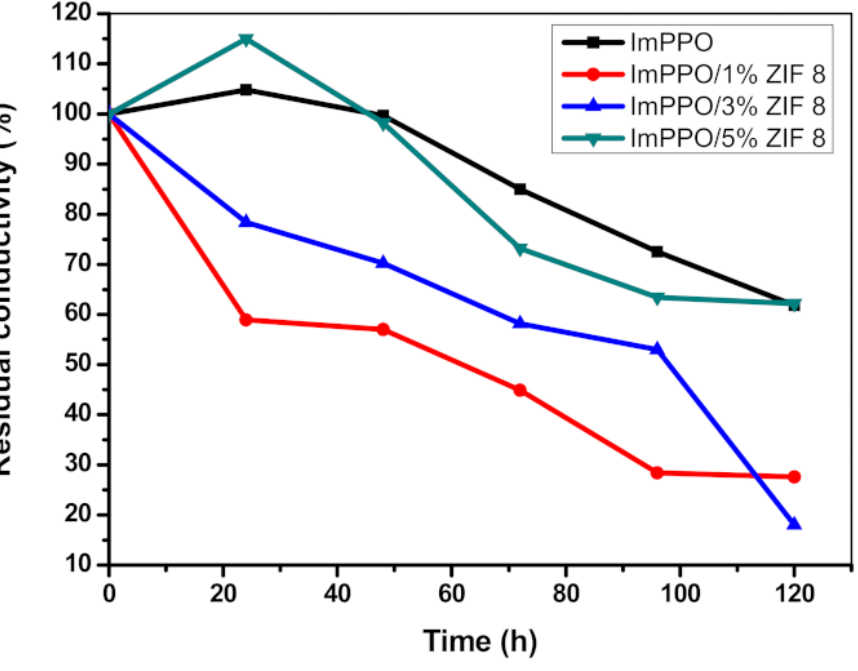
Figure 9. Alkaline stability of IMPPO/ZIF-8 membrane in 2 M NaOH